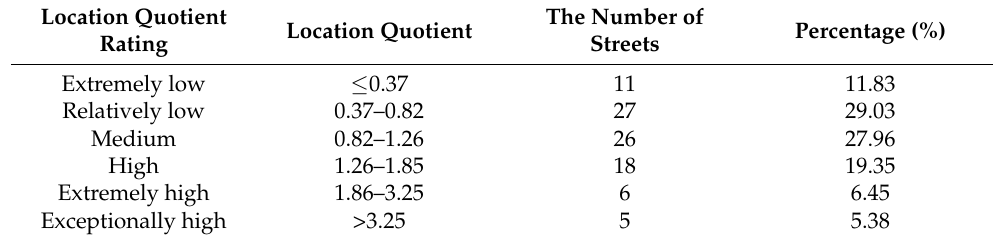
Table 1. Number and proportion of streets graded based on location quotient of the resident population.